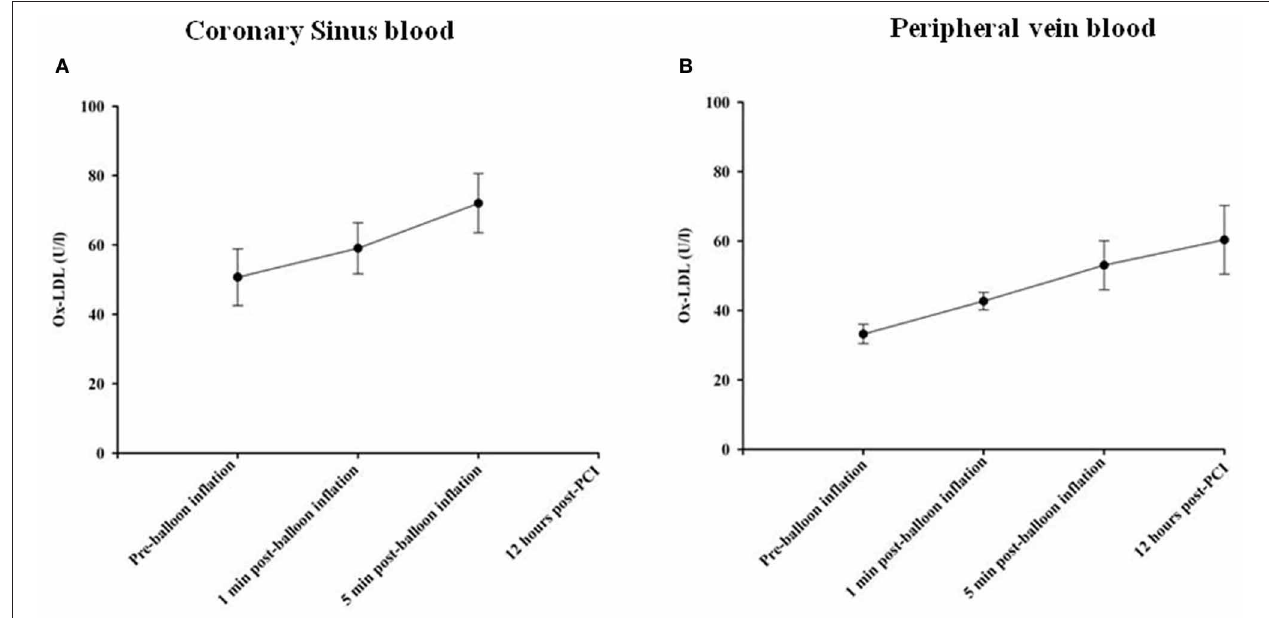
FIGURE 4 | Changes in Ox-LDL concentrations in coronary sinus (A) and peripheral (B) blood at different time course points following balloon inflation.